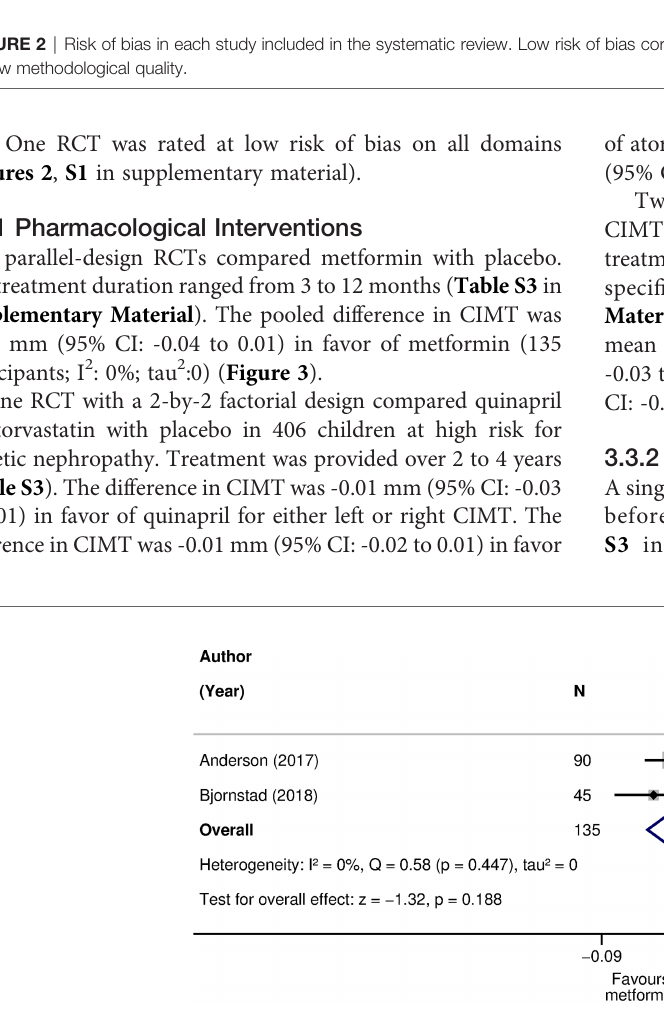
FIGURE 3 | The effect of metformin compared with placebo on CIMT in children with type 1 diabetes. The effect is the difference in CIMT mean scores at follow-up (42) or in mean change scores from baseline to follow-up (43) in mm. A negative effect size corresponds to a lower CIMT in the metformin arm as opposed to the placebo arm. Weights are from the random-effects model. CI, con fi dence interval; CIMT, carotid intima-media thickness; N, sample size; Q, Cochran ’ s Q statistic; p, p-value; z, z statistic for the overall